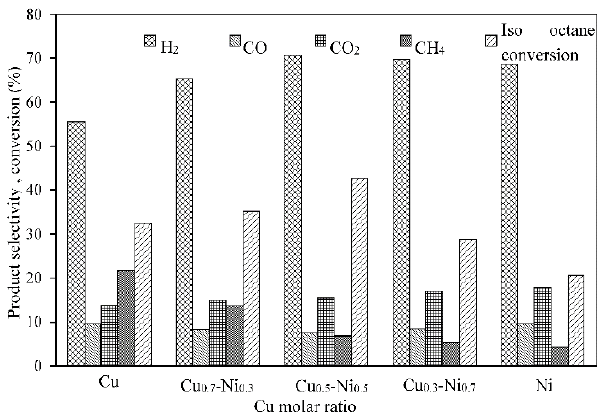
Figure 11. Effect of Cu molar ratio on conversion and product selectivity over 18 wt. % Cu ‐ Ni/Al 2 O 3 catalyst; T = 550 °C, N 2 = 15 cm 3 /min; iso ‐ octane feed rate was 0.03 g/min; S/C molar ratio: 0.9.